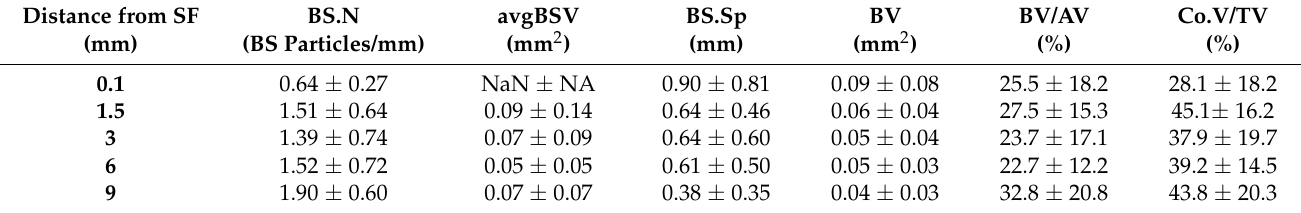
Table 3. Descriptive statistics for histomorphometric parameters (secondary measurements) in 0.5 mm windows at certain distances from the sinus floor: In order to illustrate the spatial distribution of the histomorphometric parameters at certain distances from the SF, measurements were averaged in 0.5 mm windows starting from the borderline of the native bone of the SF (0 mm representing the zero reference) towards the apical end of biopsies. Values are presented as mean ± standard